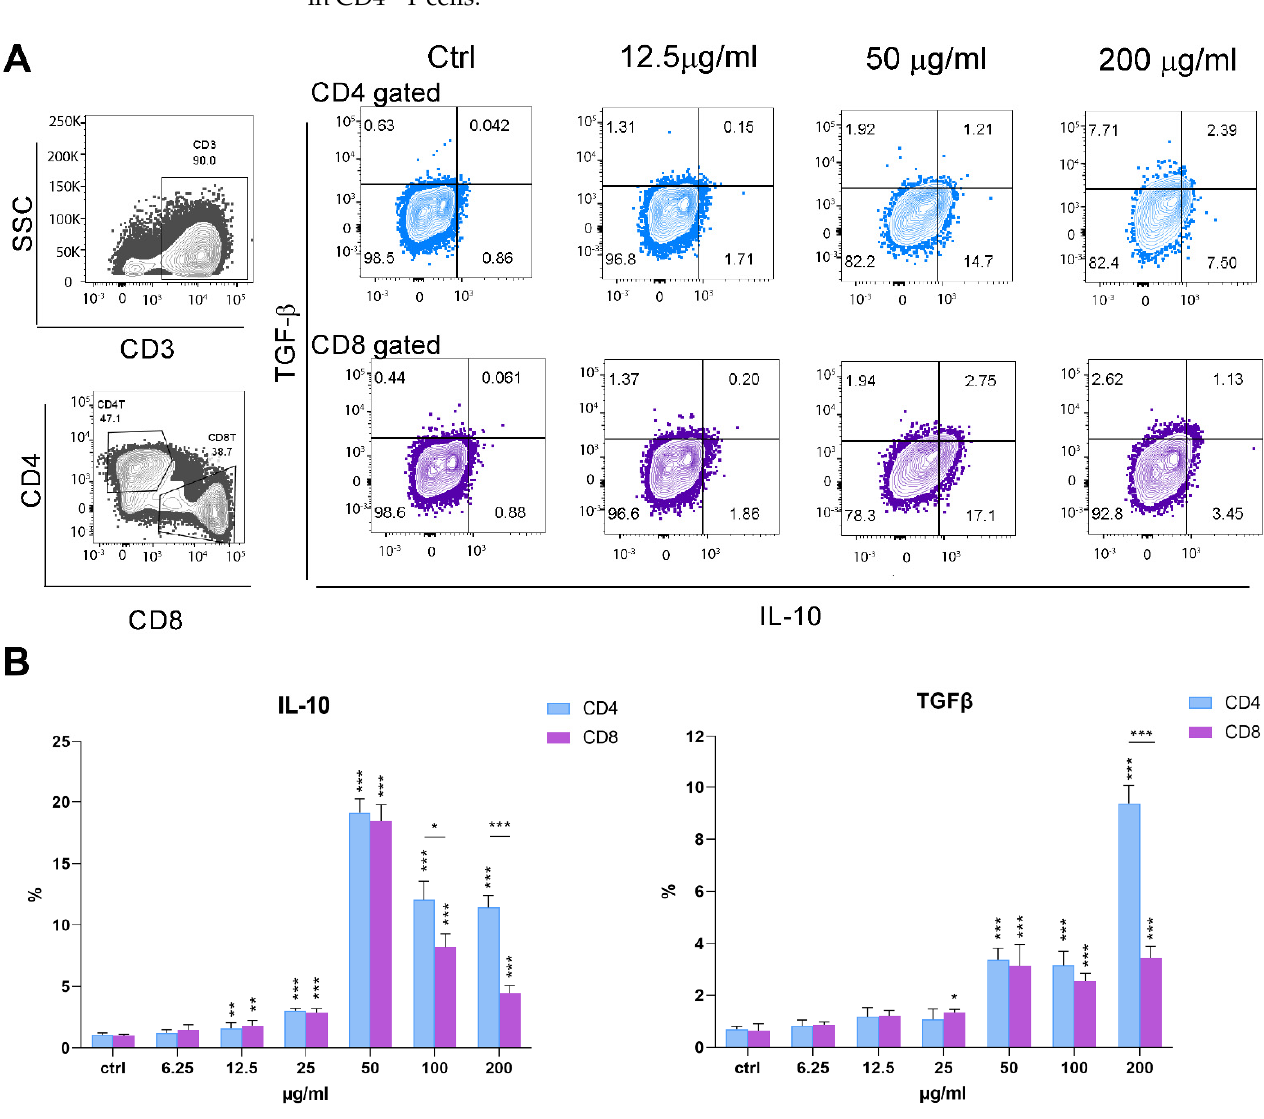
Figure 9. The effects of PoPEx on the expression of IL-10 and TGF- β in PHA-stimulated PBMC. PBMC (3 × 10 5 /well) were culured with PoPEx (6.25–200 µg/mL) or without PoPEx (ctrl), in the presence of PHA (10 µg/mL) for 3 days. ( A ) A representative analysis of IL-10 and TGF- β is shown, as determined within CD3 + CD4 + (light blue) or CD3 + CD8 + T-cells (purple), and ( B ) the summarized data is shown as mean% ± SD (n = 3). * p < 0.05, ** p < 0.01, *** p < 0.005, compared to control non-treated PHA-PBMC or as indicated by line (One-way ANOVA; Dunn’s multiple comparison post-test). When the frequency of Tregs was analyzed within CD4 + T-cells (CD4 + CD25 hi Foxp3 + ) (Figure 10A,B), its proportion was higher in the presence of a lower concentration of PoPEx (12.5 µ g/mL). Although the proportions of IL-10 + Tregs and TGF- β + Tregs were very